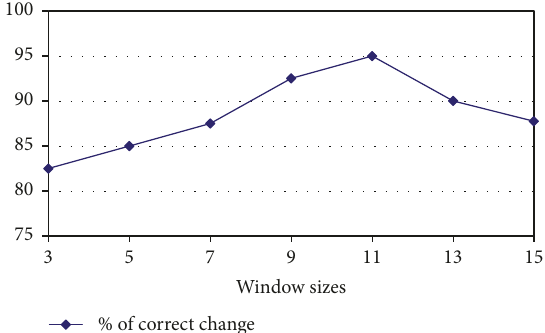
Figure 5: Relationship between window sizes and (%) of correct